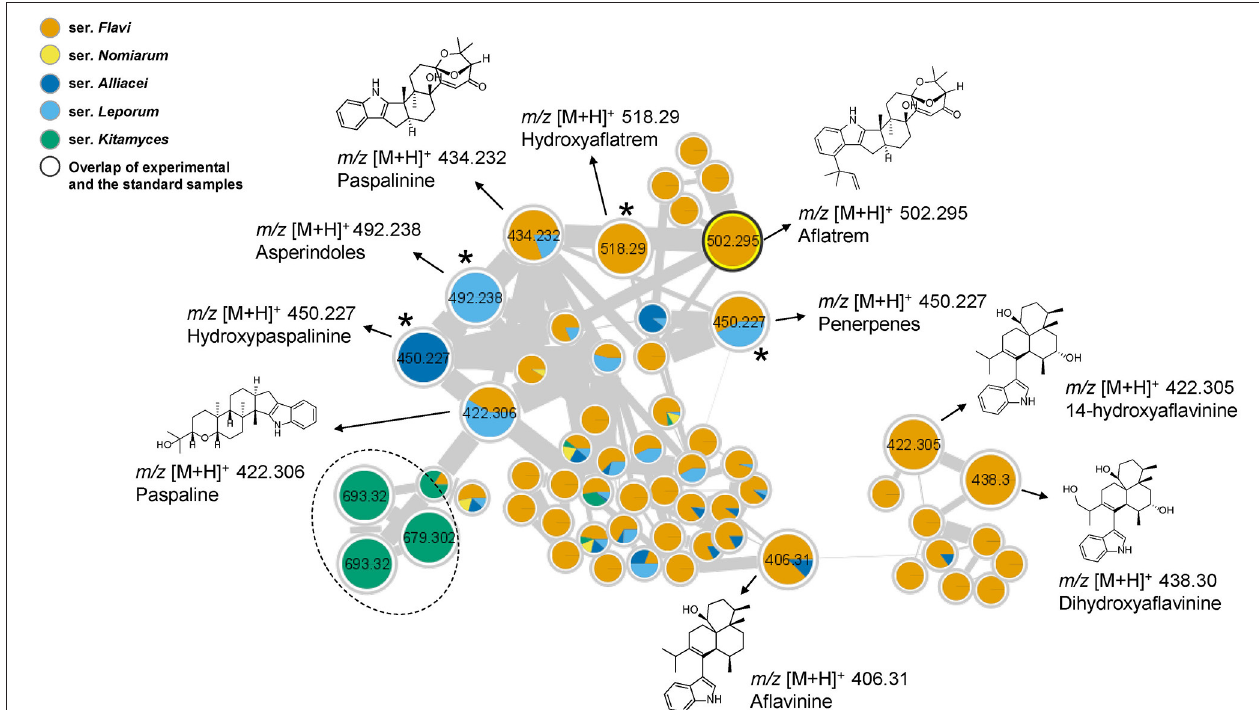
FIGURE 5 | Cluster of aflatrems and related compounds. Nodes with bold outlined black circles are the overlap of molecules and the standard compounds, the nodes marked with asterisk are the molecules found from the structural relationship shown in molecular networks. The products inside the dotted line are only produced in series Kitamyces